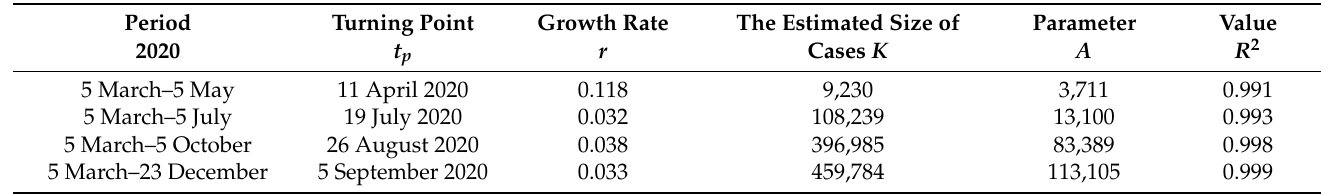
Table 4. The estimation results of parameters in the logistic growth model for various periods from daily cases data of COVID-19 infected in the Philippines based on data compiled by WHO [18].